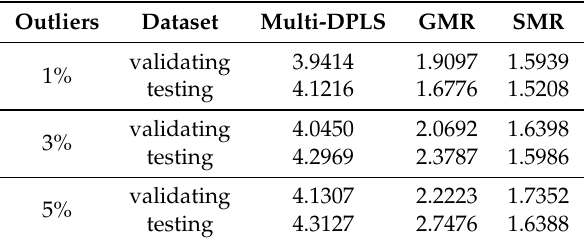
Table 2. RMSE of various methods on the validating and testing